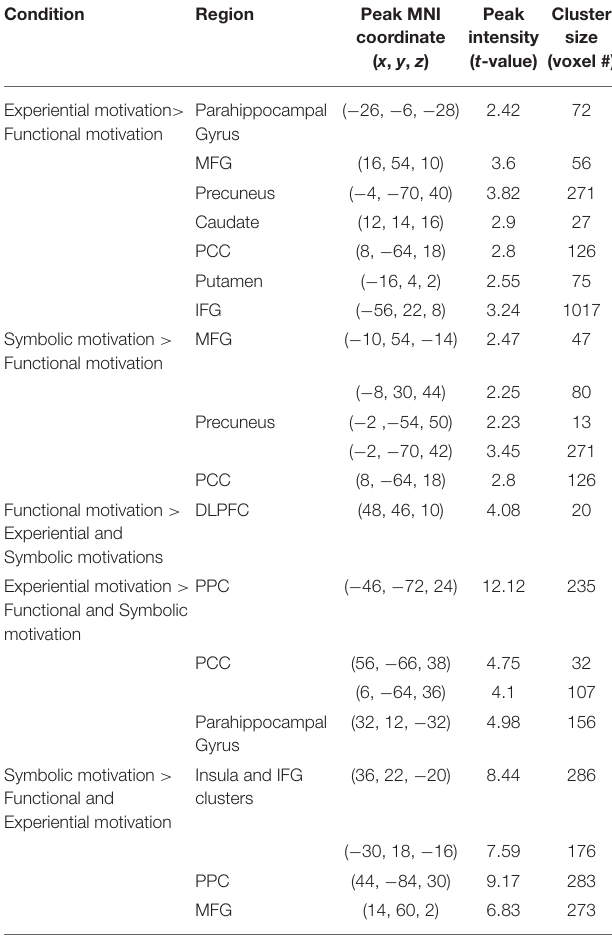
TABLE 2 | Summary results from the functional contrasts of the motivation conditions.